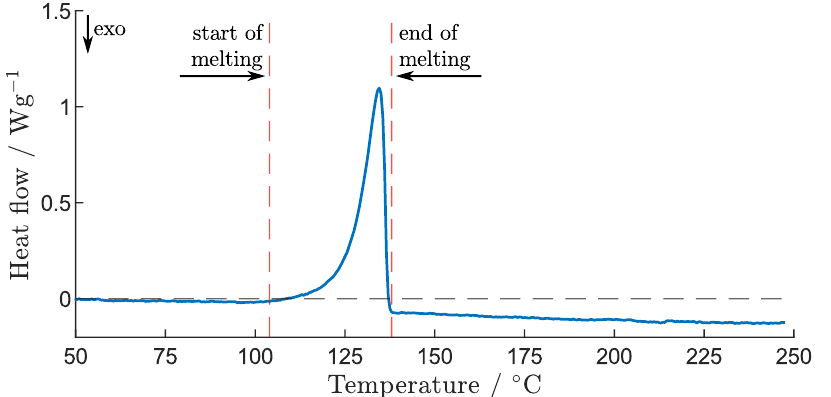
Figure 7. DSC result of the separator material without ceramic coating of the aged type 1 cell, with the beginning and end of melting marked by red dashed